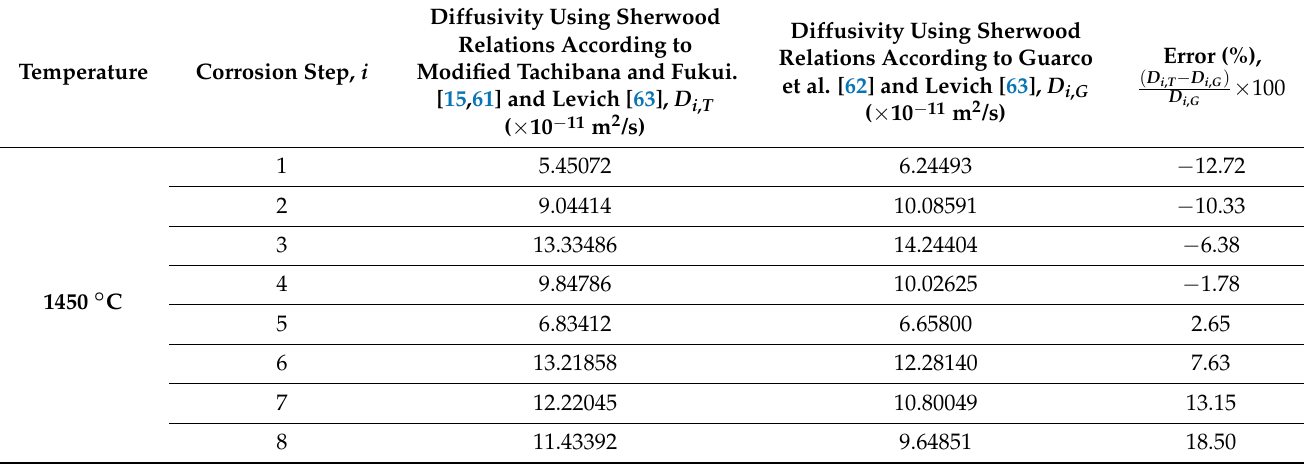
Table 4. Comparison of the diffusivities of magnesia using different Sherwood